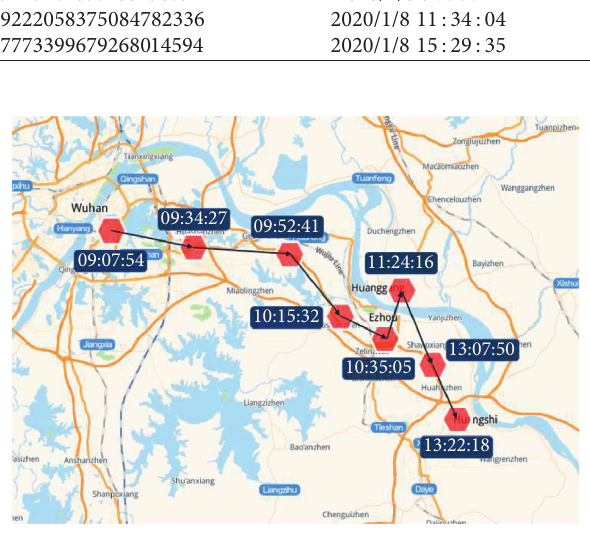
Figure 1: Example of a track extracted from CDR data—polygons indicate the coverage of the base